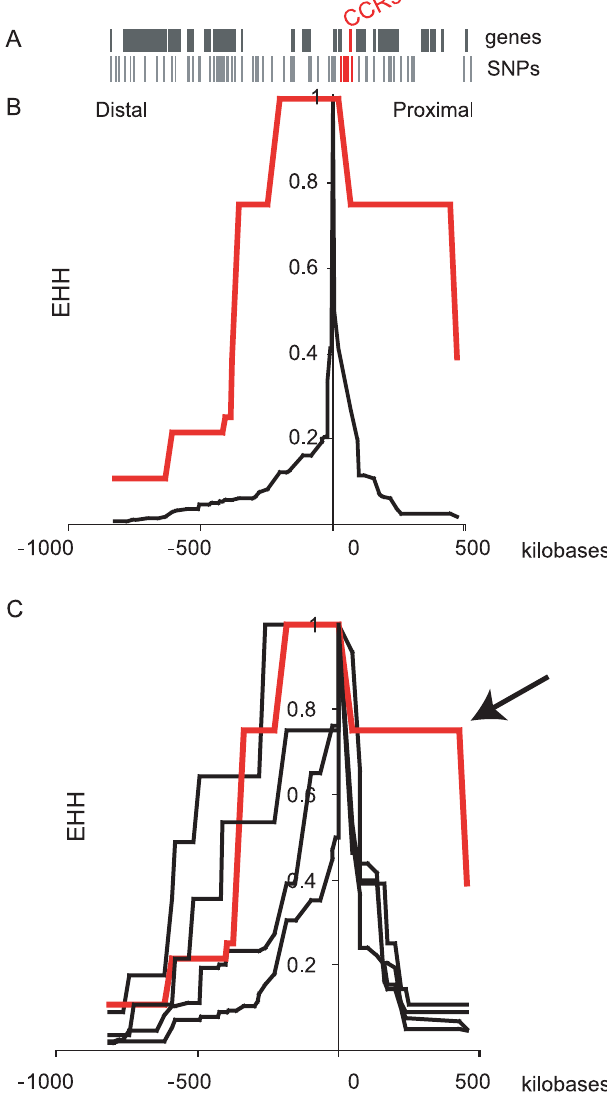
Figure 1. EHH Breakdown of EHH over Distance between the CCR5- D 32 Mutation and 63 SNPs at Increasing Distances from the Mutation. (A) Map of SNPs typed. (B) Comparison between D 32 and a single non- D 32 class of haplotypes. It should be noted that the D 32 -bearing chromosomes appear (red) to have greatly extended LD compared to the non- D 32 -bearing chromo- somes (black). (C) Breakdown using the eight-marker haplotype containing the D 32 mutation. There are five haplotypes in European-Americans (frequencies: 42%, 31%, 10%, 8%, and 8%, respectively). Full haplotype sequences and frequencies in other populations are given in Table S3. Notice that two of the non- D 32 -bearing chromosomes (black) appear to have the similar extended LD when compared to the D 32 -bearing chromosomes centromere-distal to CCR5 (red). Centromere-proximal D 32 -bearing chromosomes still have the most extended LD, indicated with an arrow. DOI: classes based on their genotype at CCR5- D 32, rather than dividing them according to the full variation seen at CCR5.